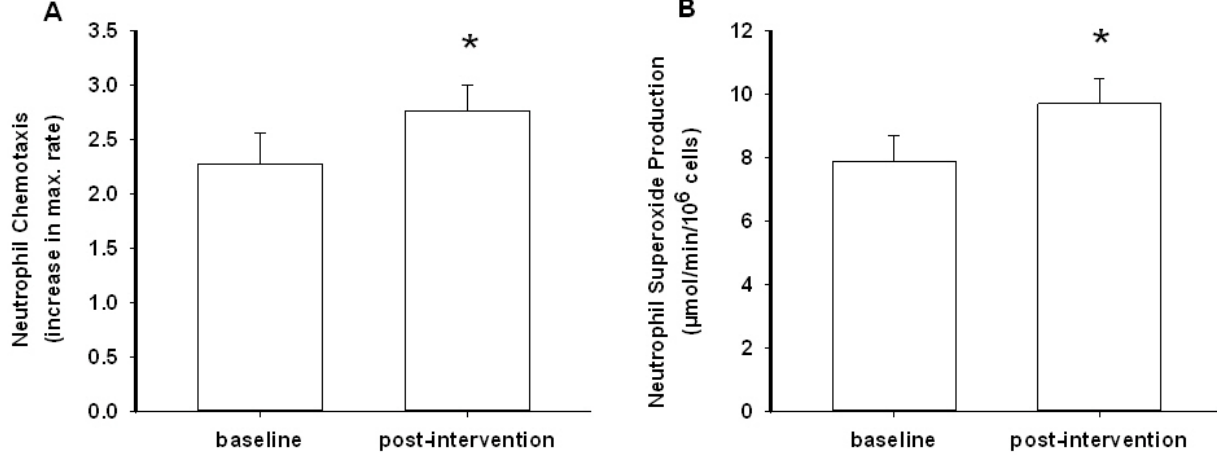
Figure 2. Neutrophil chemotaxis ( A ) and superoxide generation ( B ) at baseline and post-intervention. Data represent mean ± SEM ( n = 12 and 11), * = p <